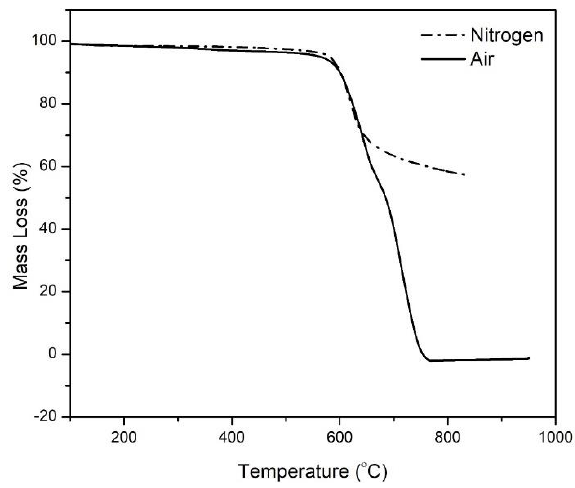
Figure 1. Thermogravimetric mass loss profiles of neat polyimide in air and nitrogen.